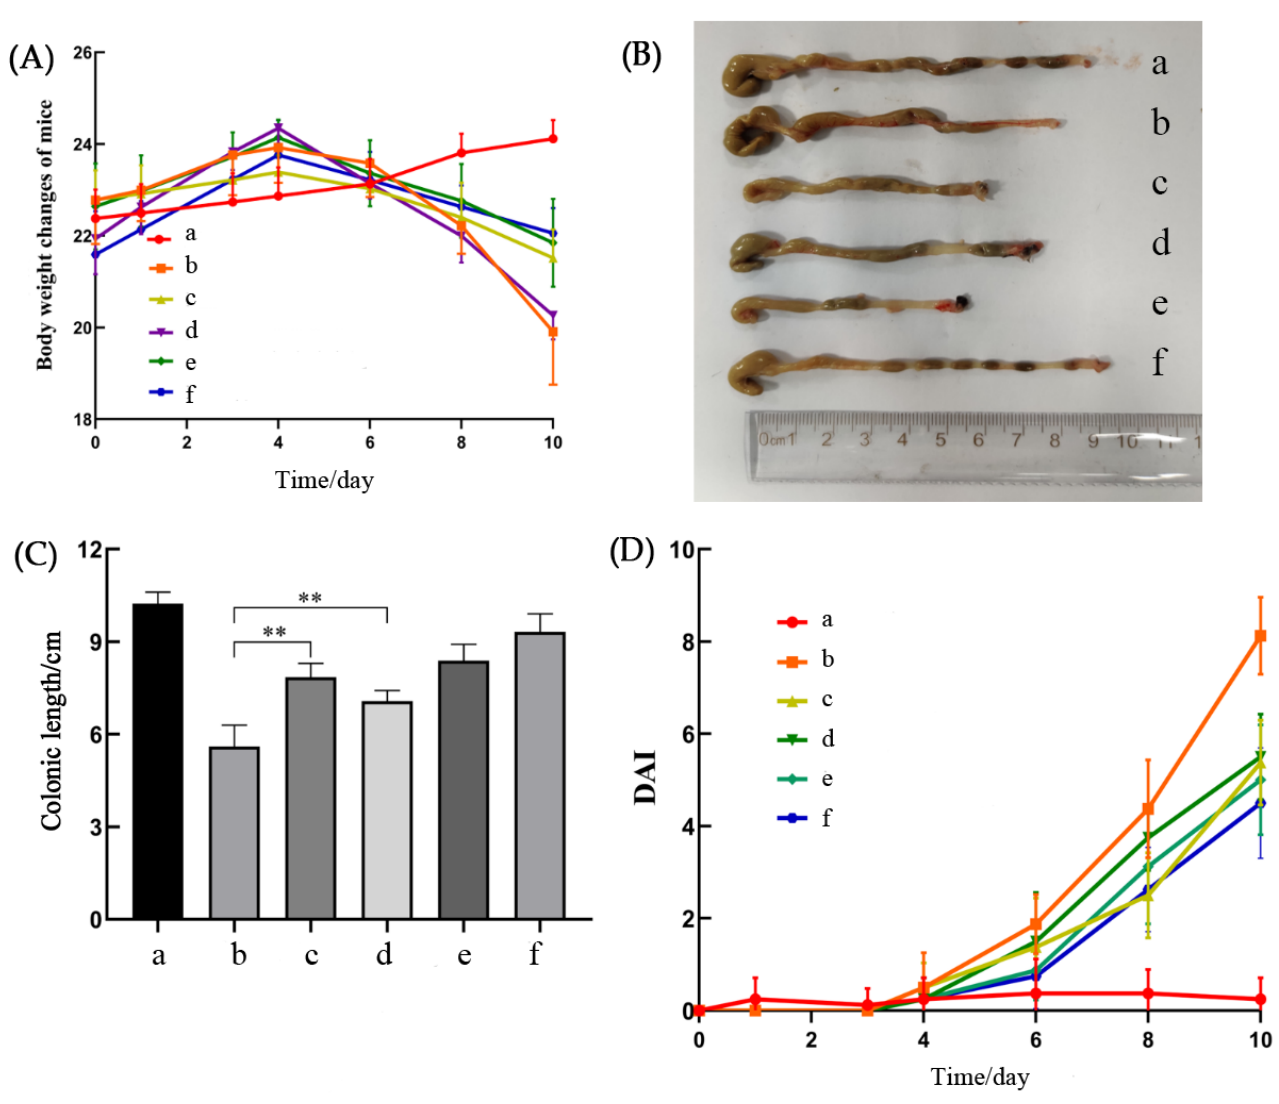
Figure 5. The protective effect of total flavonoids of A. senticosus on DSS-induced UC. ( A ) Measure- ment results for changes in body weights of mice in each group. ( B ) Picture comparing the lengths of the colons of each group of mice. ( C ) Results of measuring the colon length for each group of mice. ( D ) During the experiment, the trend of the DAI score of each group of mice. Legend description: a, blank group; b, DSS group; c, mesalazine group; d, A. senticosus low-dose group; e, A. senticosus medium-dose group; f, A. senticosus high-dose group. Note: For the comparison between the two groups, ** indicates extremely significant difference at p <